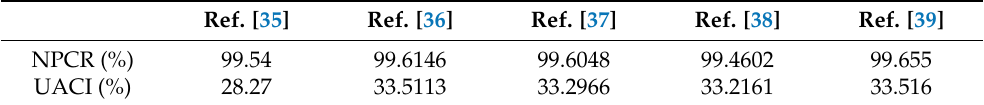
Table 7. The comparison results of NPCR and